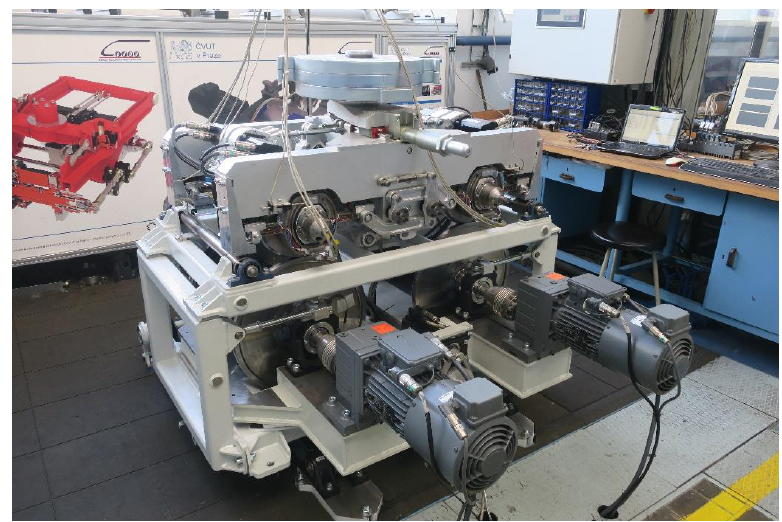
Figure 5. Scaled roller rig of the Czech Technical University.